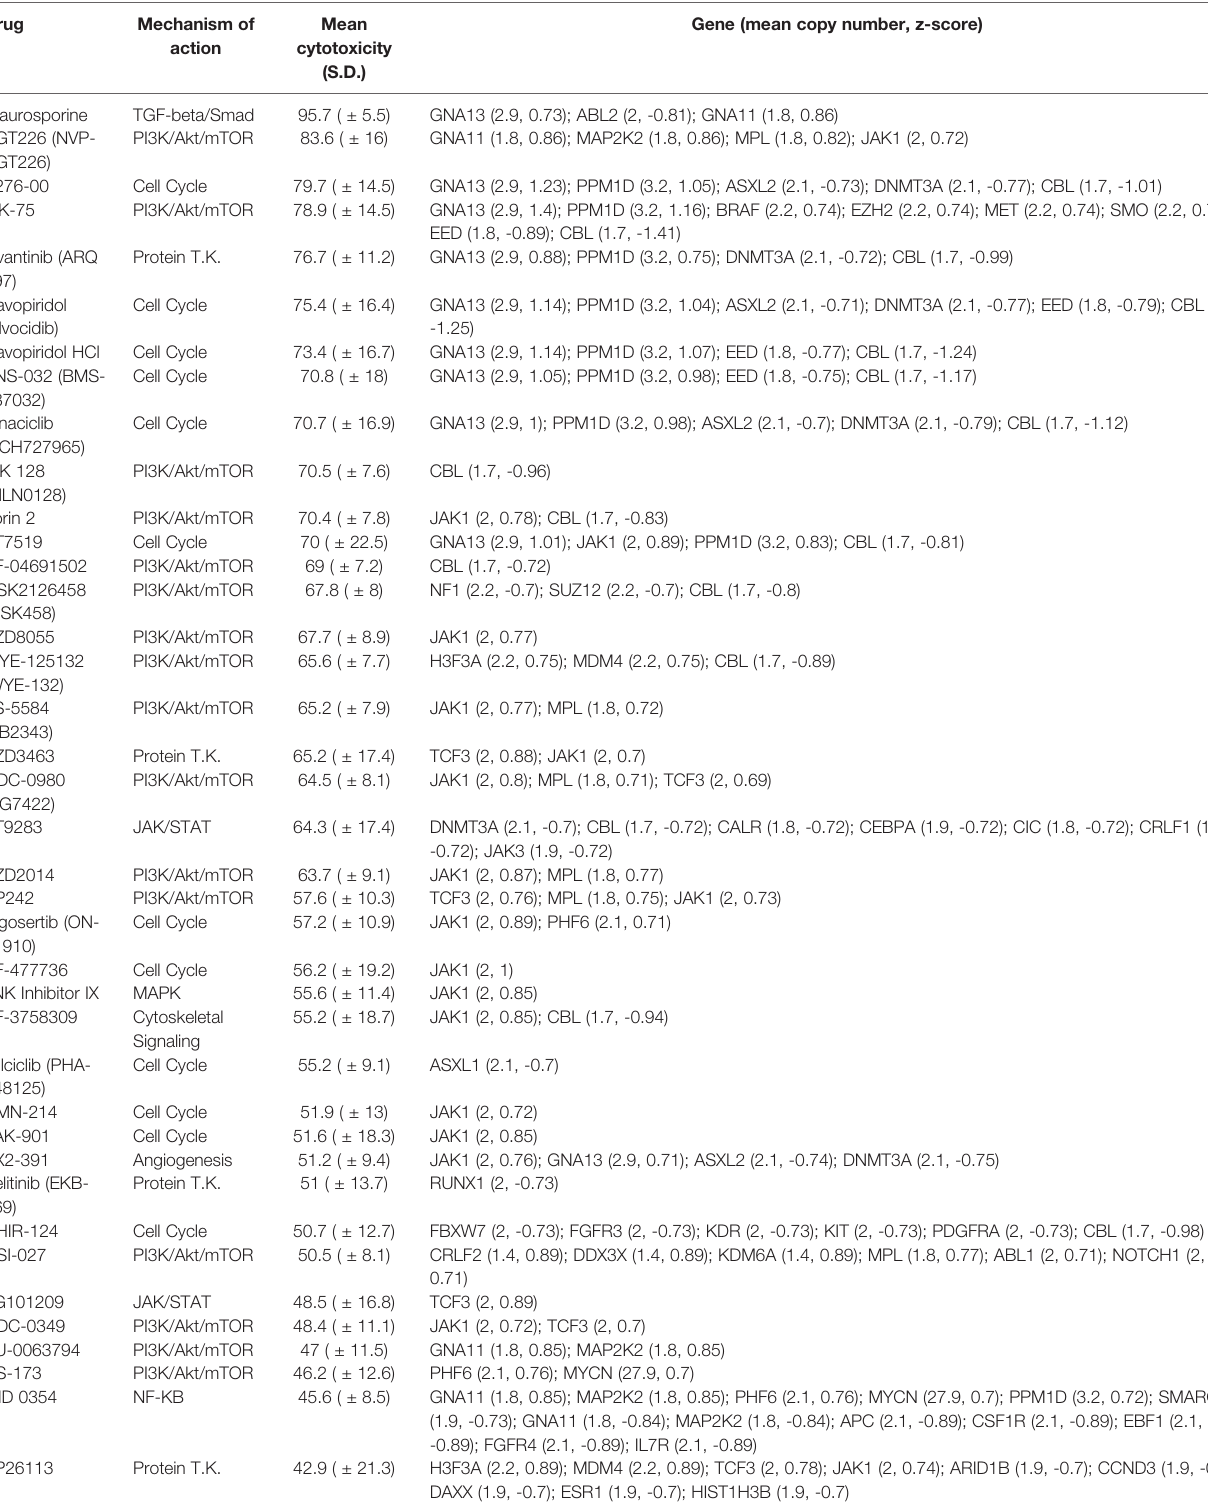
TABLE 1 | Pairs of drug hits and corresponding genes with signi fi cant association between cytotoxicity and copy number. Drug Mechanism of